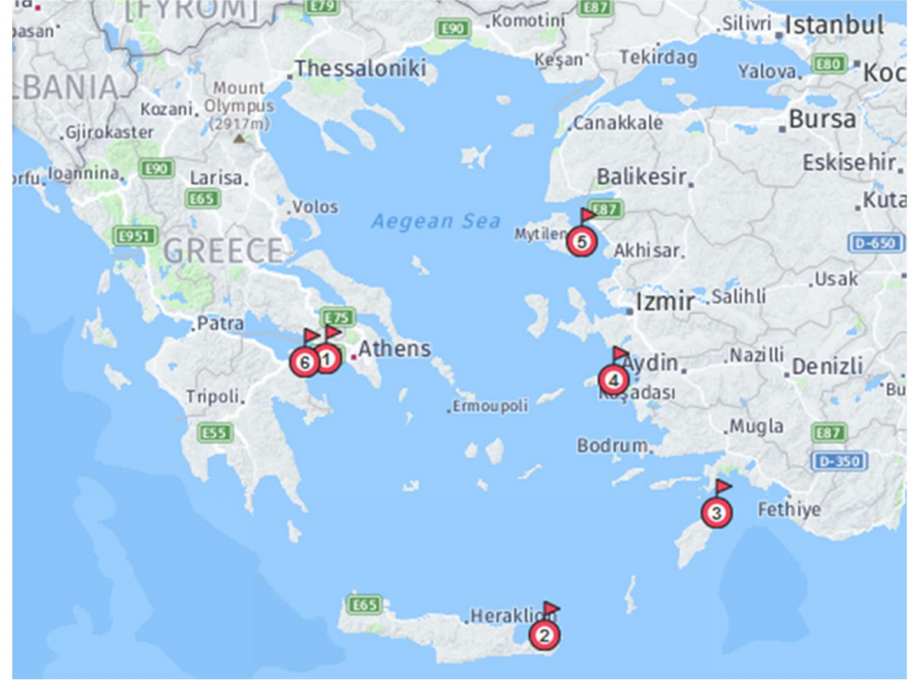
Figure 2. The six points of interest in the Greek territory.